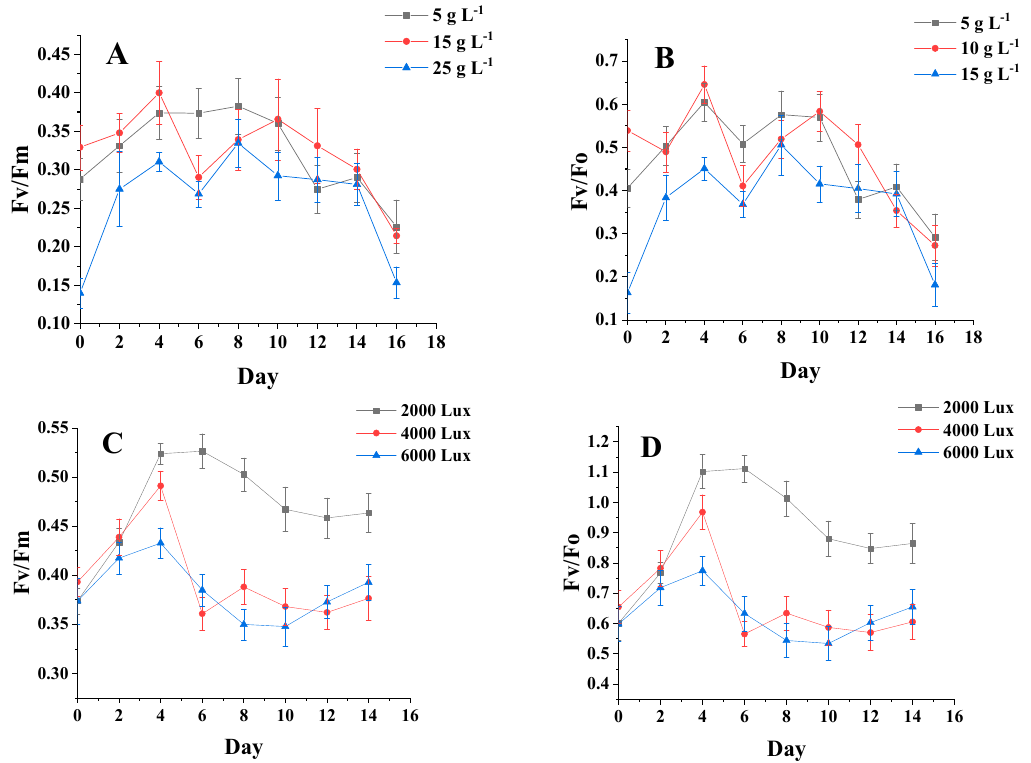
Figure 5. Chlorophyll fluorescence parameters under different culture conditions. ( A , B ) represents Fv/Fm and Fv/Fo at different NaCl concentrations; ( C , D ) represents Fv/Fm and Fv/Fo at different light conditions). The results are presented as mean ± SE ( n = 3).